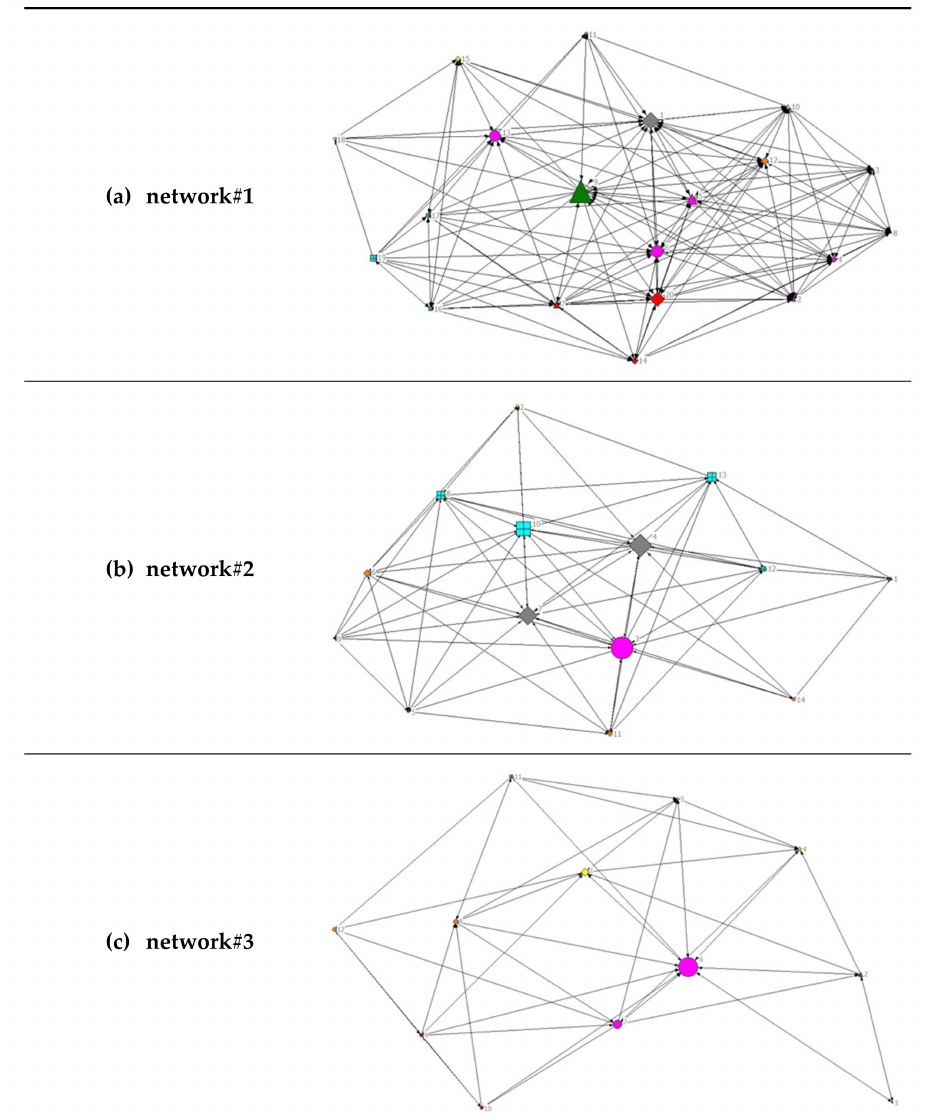
Figure 2. Visualization of network data for all networks. ( a ) Network#1: size = 20, density = 48%; ( b ) network#2, size = 14, density 52%; ( c ) network#3, size = 12, density 42%. Node size by betweenness. Colors by subject area: pink, health; green, nutrition; yellow, sports/exercise; orange, leisure; red, family; turquoise, elementary schools; grey, social and educational institutions. Symbols by structural level: circle, office level; up triangle, network level; square, association level; box, elementary